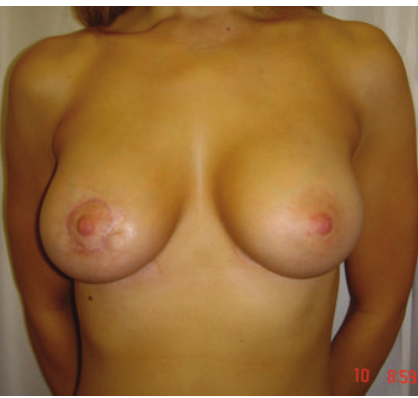
Figure 2: This patient presented with a 1 cm tumour located in the upper inner quadrant of the right breast. The tumour was excised via a periareolar incision and the remaining breast tissue was mobilised to close the defect. The round block technique ensured that the nipple-areolar complex remained in the correct position.